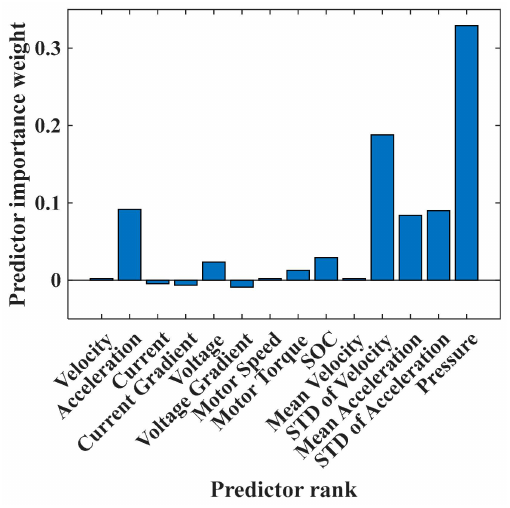
Figure 8. Rank importance analysis of each predictor during brake intensity prediction using